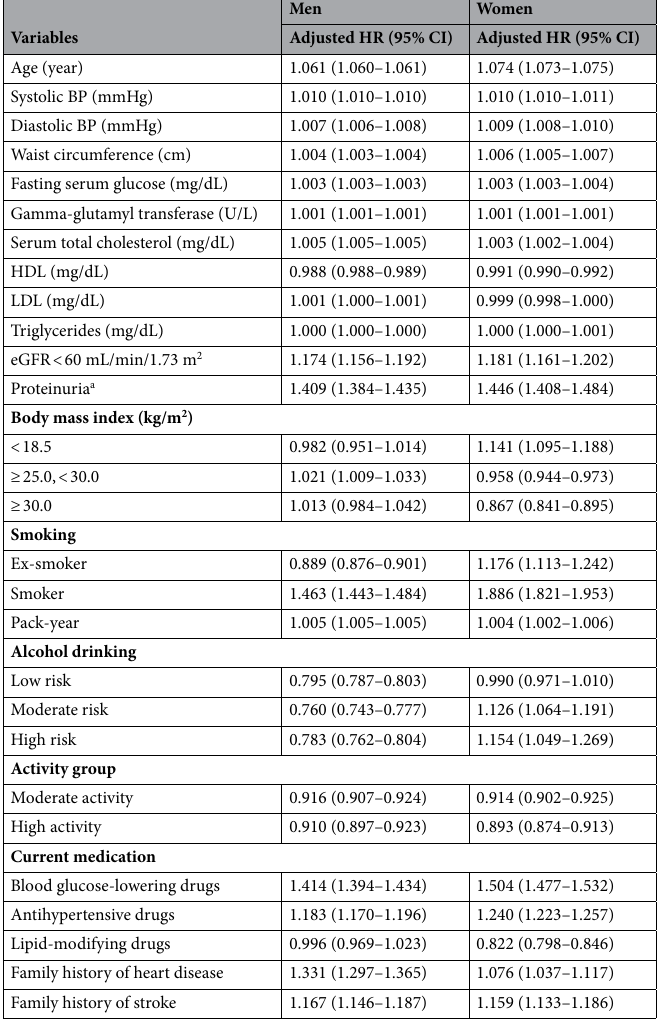
Table 2. Adjusted hazard ratios of the variables included in the CVD prediction model. S 0 (8) of men = 0.9798, S 0 (8) of women = 0.9916. Covariates included in Cox models were selected by stepwise procedures. HR hazard ratio, CI confidence interval, BP blood pressure, HDL high-density lipoprotein cholesterol, LDL low-density lipoprotein cholesterol, eGFR estimated glomerular filtration rate. a ≥ 1 + in urine dipstick for